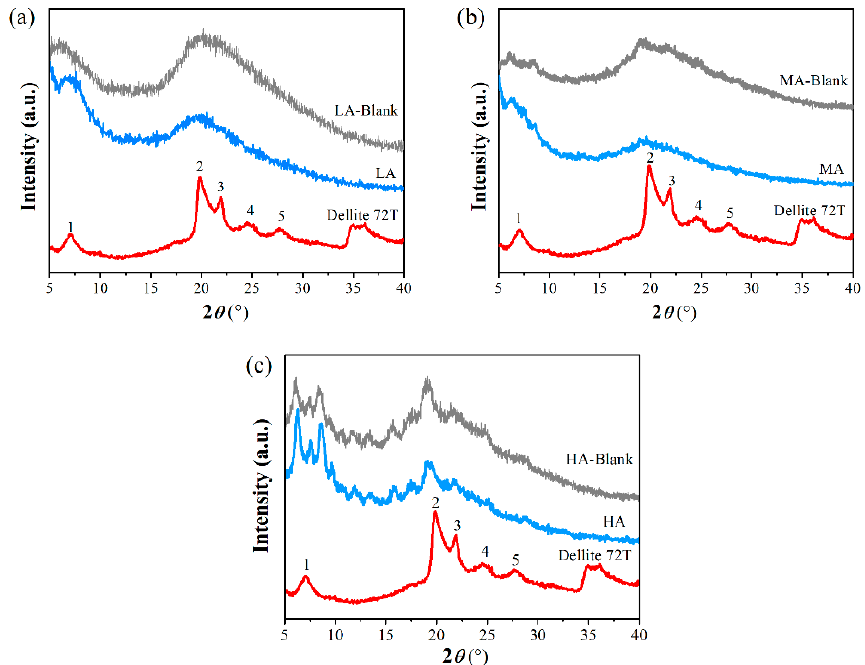
Figure 4. XRD data of starch-based films and OMMT (the curves have been shifted vertically to avoid overlapping). ( a ) LA, ( b ) MA, and ( c ) HA. “–Blank” represented for the corresponding starch-based films without nanofiller.